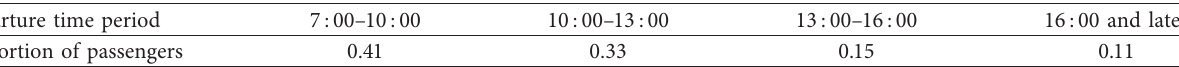
Table 2: Proportion of passengers’ departure time intention in each time